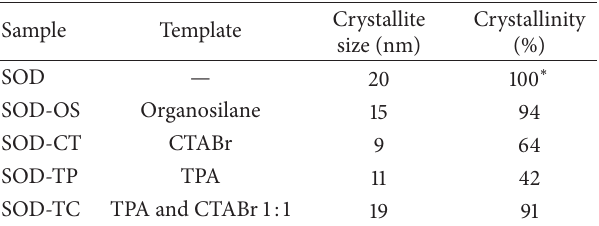
Table1:Thecrystallitesizeandcrystallinityofsodaliteformedusing different templates.